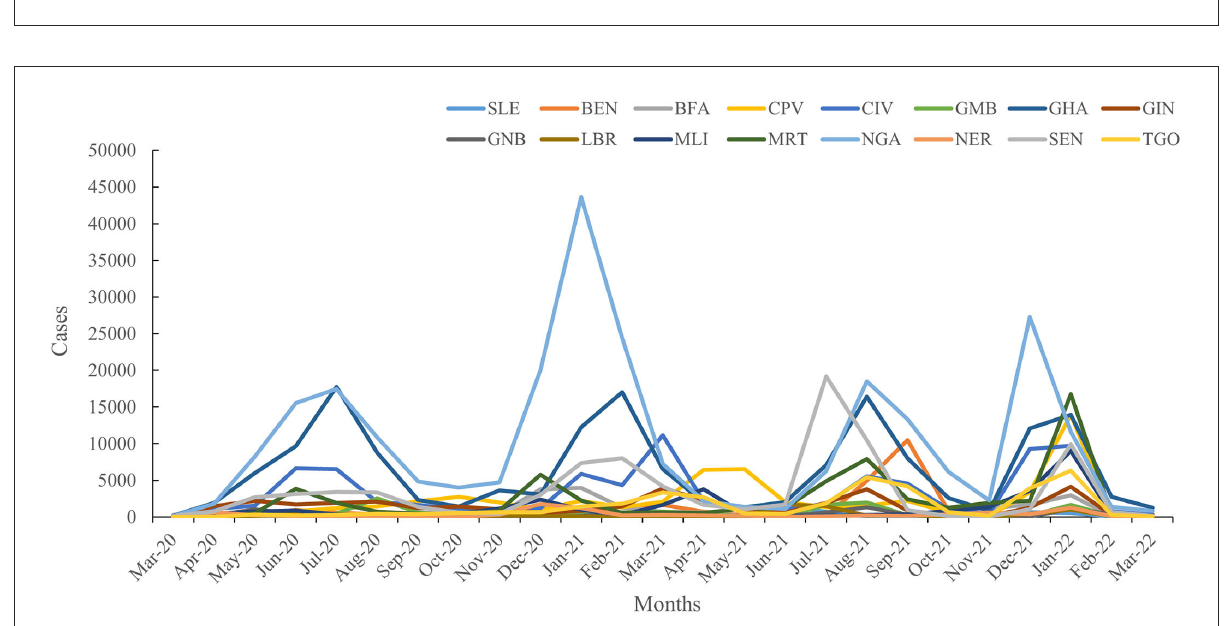
FIGURE2 Epidemiological trends in the 16 countries in West Africa from March 2020 to March